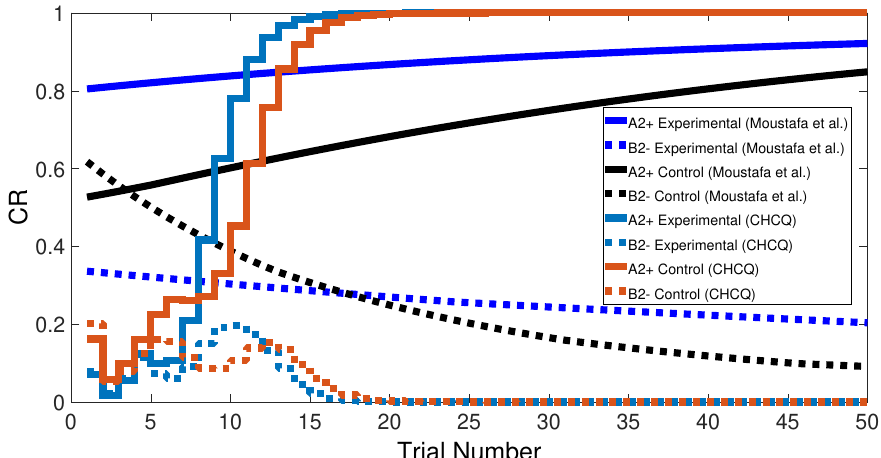
Figure 21. Easy–Hard transfer task of CHCQ model compared with the model of Moustafa et